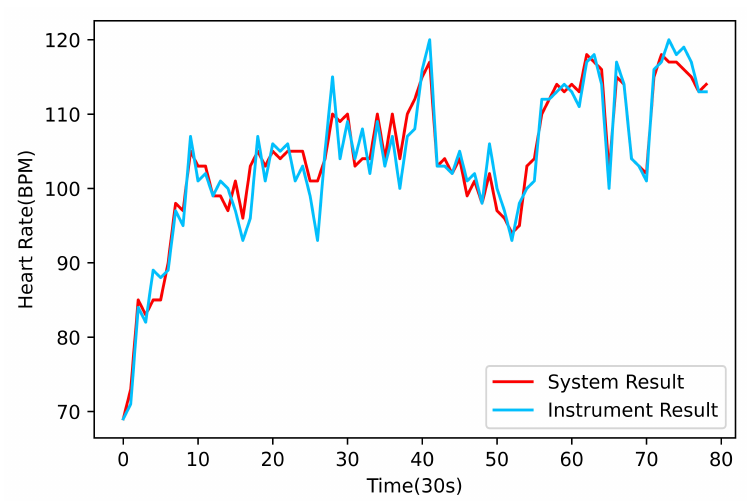
Figure 11. The results of the finger clip heart rate instrument and the monitoring system designed in this